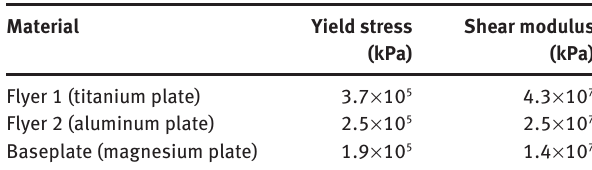
Table 2: Parameters of the three-layer plates used in the von Mises model.